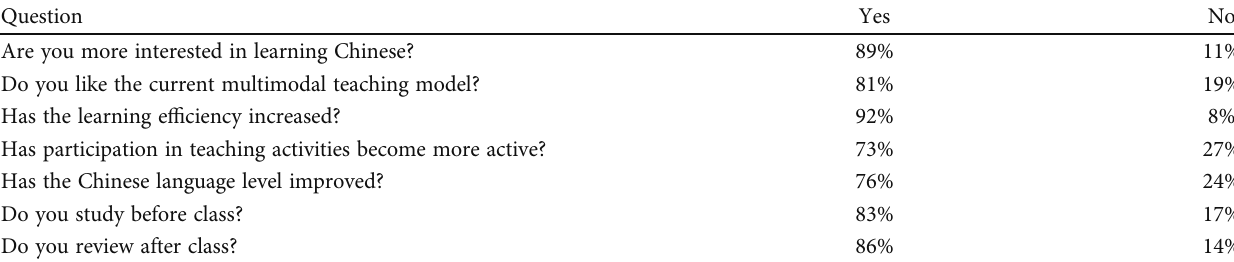
Table 2: Result of questionnaire after applying the multimodal teaching